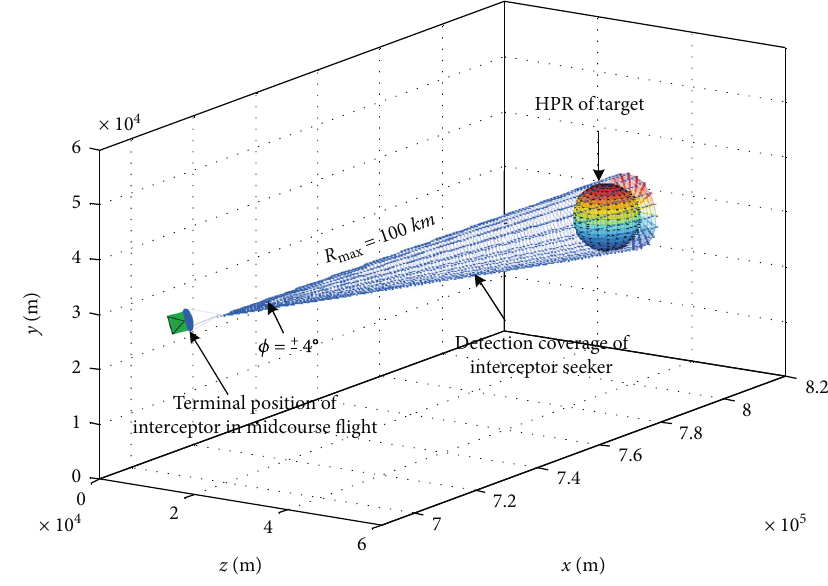
Figure 7: Handover of improved hp.